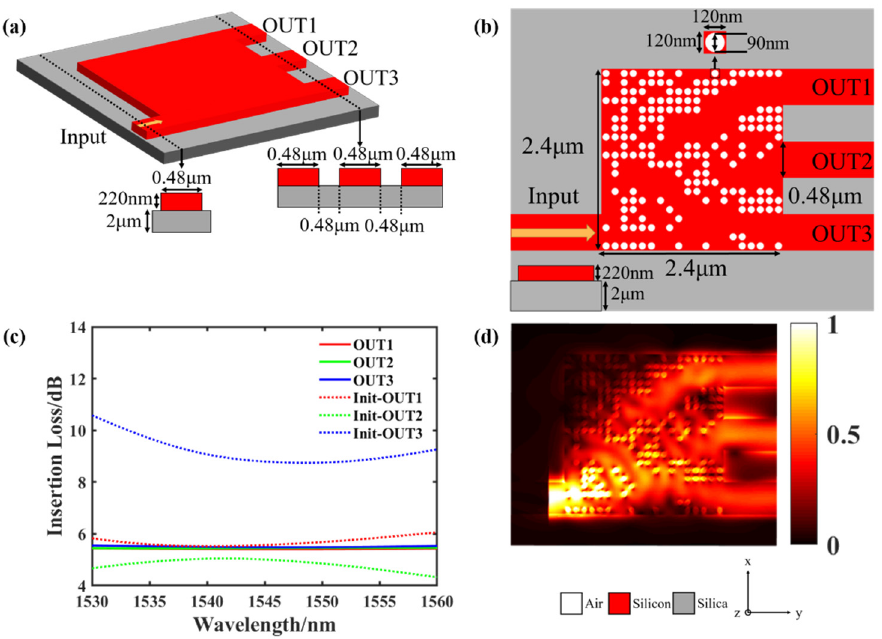
Figure 1. The simulated results of RRRPS. ( a ) Initial structure before optimization. ( b ) The final structure after optimization. ( c ) is a comparison chart of the insertion loss before and after optimization of RRRPS. ( d ) Simulated optical field distributions.